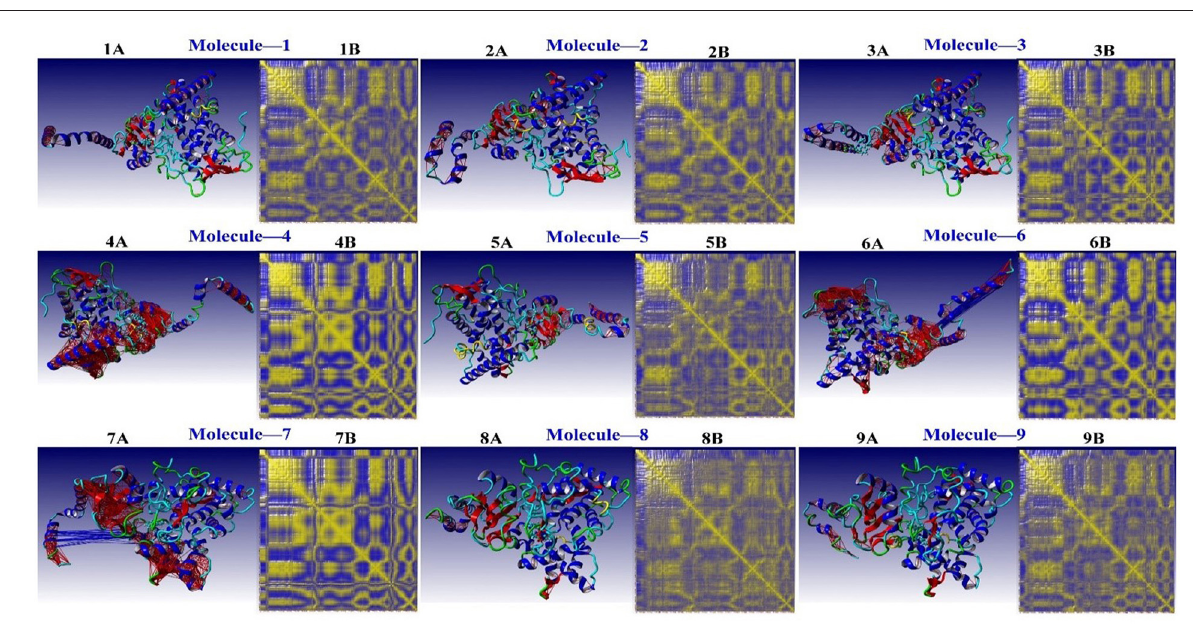
Frontiers in Medical Technology |